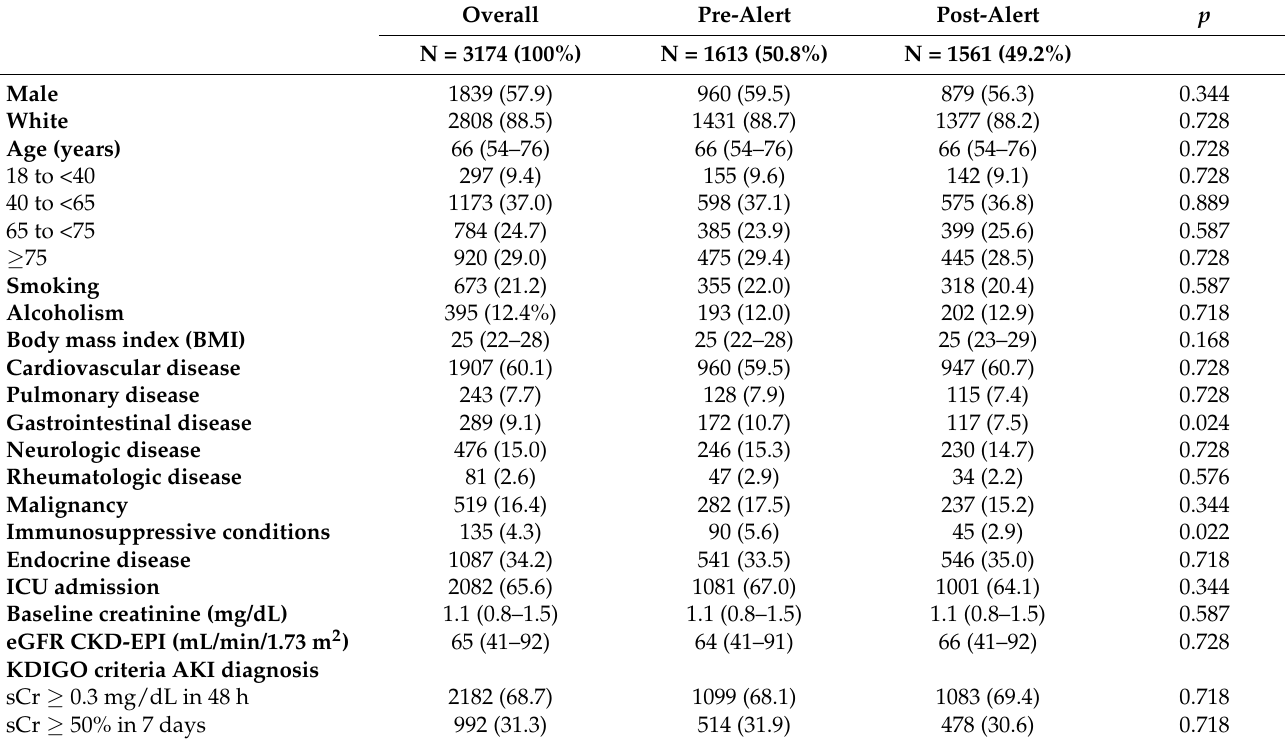
Table 1. Baseline characteristics of patients with acute kidney injury.